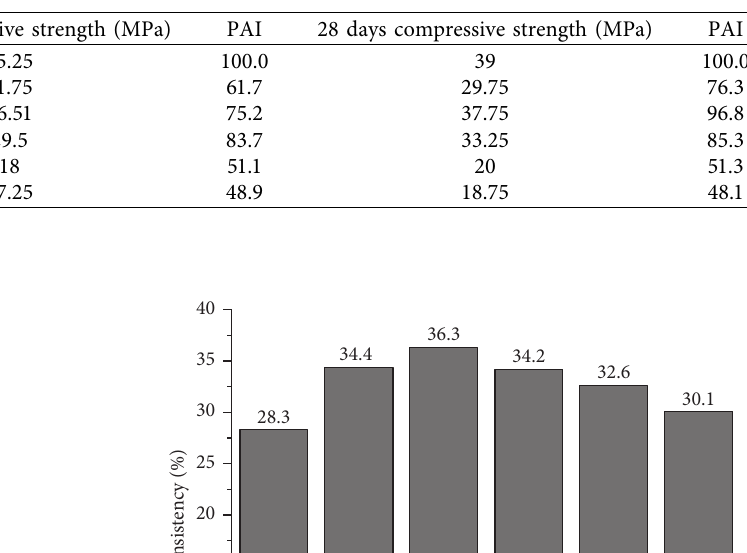
Table 3: Mix proportion and compressive strength of CSA-blended cement cubes.